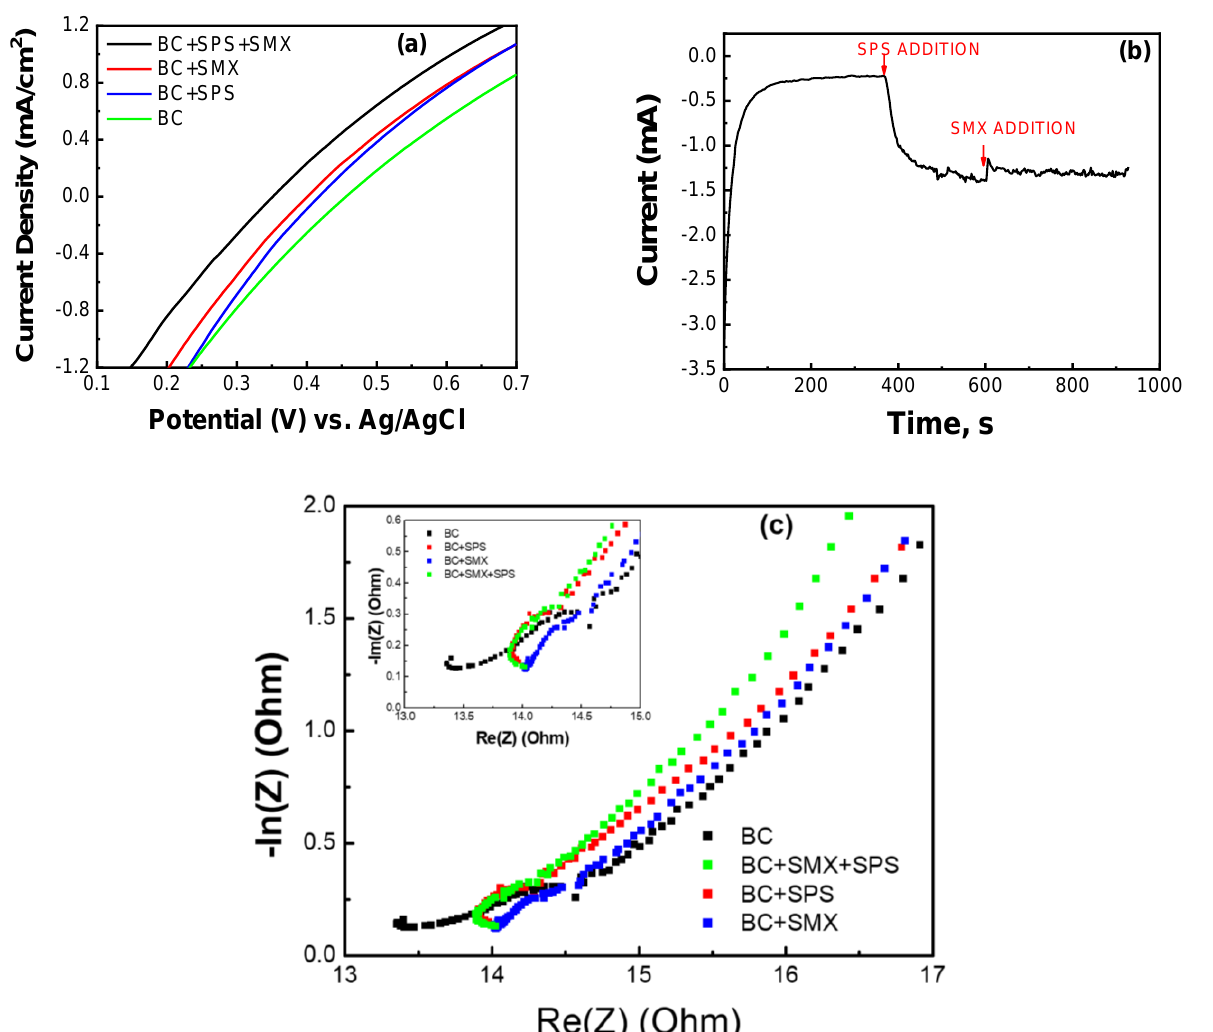
Figure 12. ( a ) LSV curves obtained under different conditions (SMX = 0.5 mg L − 1 , SPS = 250 mg L − 1 , Na 2 SO 4 = 0.1 M); ( b ) I–t curves obtained at 0 V vs. Ag/AgCl (0.1 M Na 2 SO 4 ); ( c ) EIS analysis of BC, BC/SPS, BC/SMX, and BC/SPS/SMX systems (SMX = 0.5 mg L − 1 , SPS = 250 mg L − 1 , Na 2 SO 4 = 0.1 M). Then, an amperometry measurement was carried out, applying a voltage of 0 V (vs.